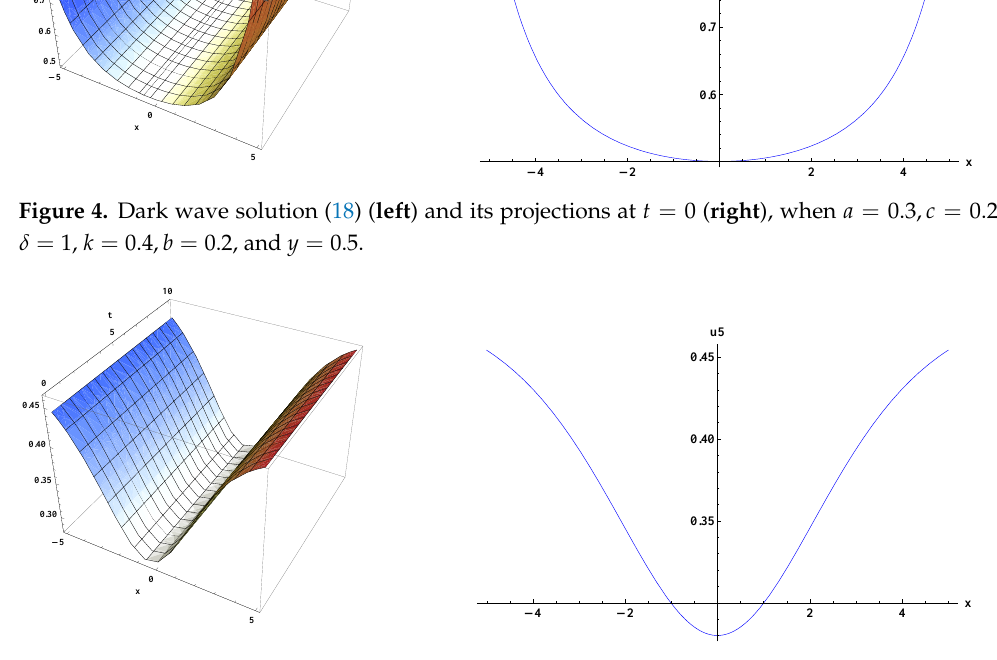
Figure 5. Dark wave solution (19) ( left ) and its projections at t = 0 ( right ), when a = δ = 1, k = 0.5, b = 0.3, and y = 0.5.